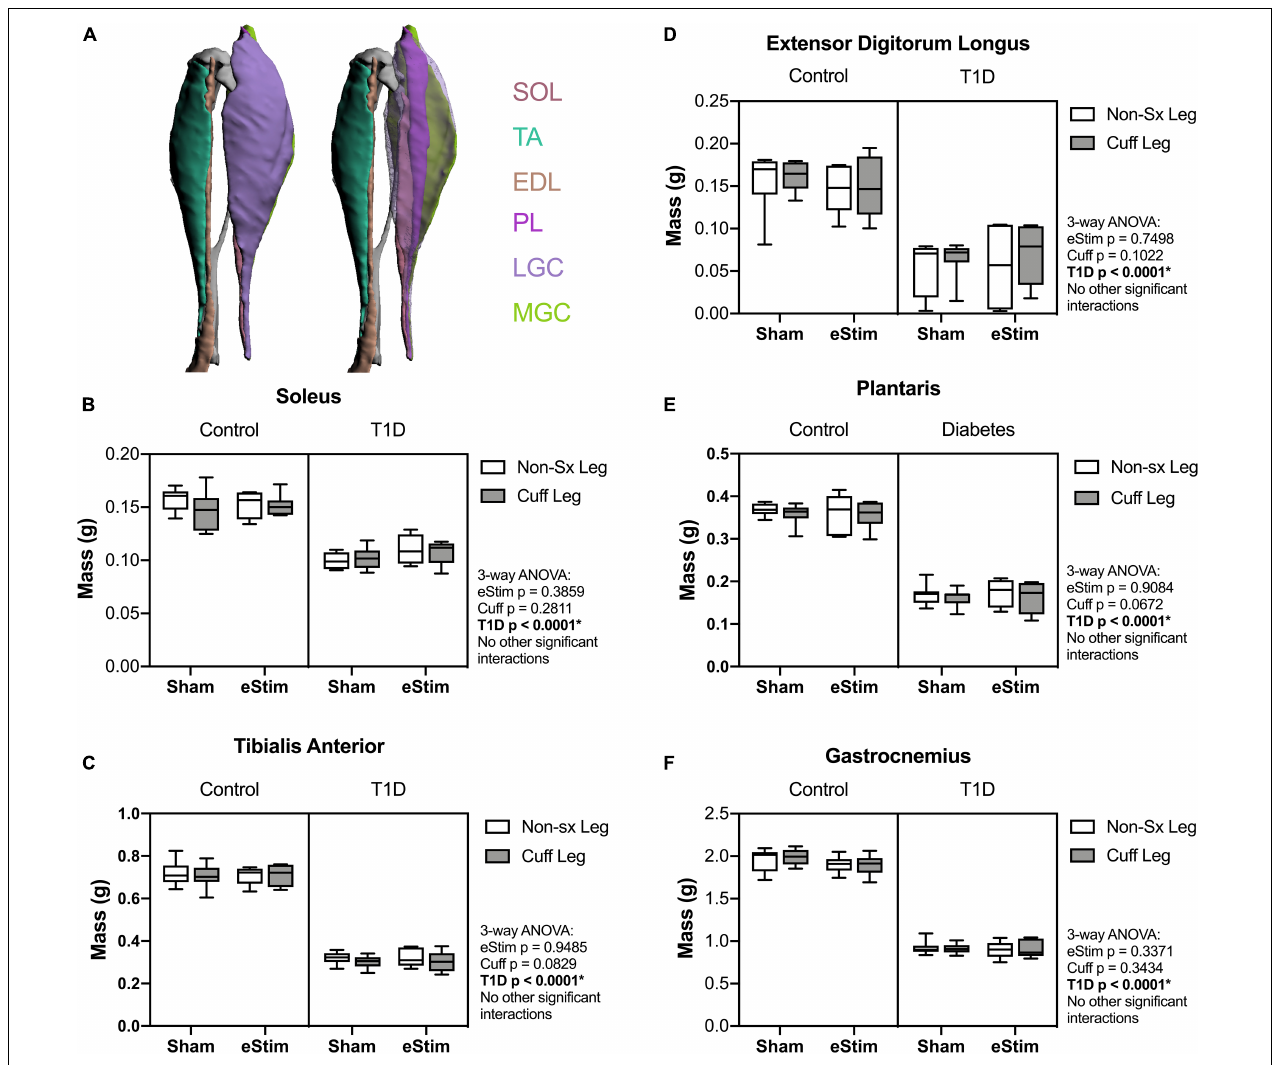
FIGURE 3 | Muscle mass. At end point, muscles surrounding the tibia (A) were dissected and weighed. (B) Soleus (SOL) muscle mass. (C) Tibialis anterior (TA) muscle mass. (D) Lateral and medial gastrocnemius (LGC, MGC) combined muscle mass. (E) Extensor digitorumlongus (EDL) muscle mass. (F) Plantaris (PL) muscle mass. Control, sham n = 7; Control, eStim n = 6; Diabetic, sham n = 8; Diabetic, eStim n = 5; three-way ANOVA with repeated measures (Non-sx Leg vs. Cuff Leg); * p < 0.050. Panel A generated from Charles et al.